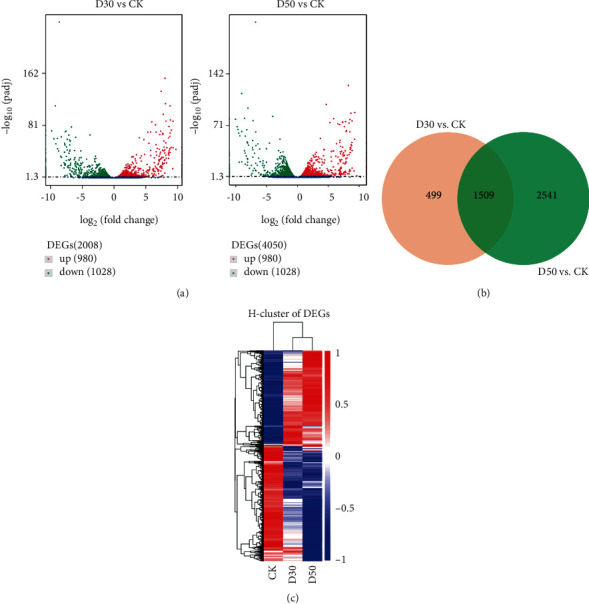
The profiles of differentially expressed genes (DEGs) in response to different irrigation regimes. (a) Volcanic map and of differentially expressed genes (DEGs). (b) Venn analysis results between D30 vs. CK and D50 vs. CK. (c) Heatmap representation of the expression profiles of the DEGs. The redder the square color, the higher the gene expression level.